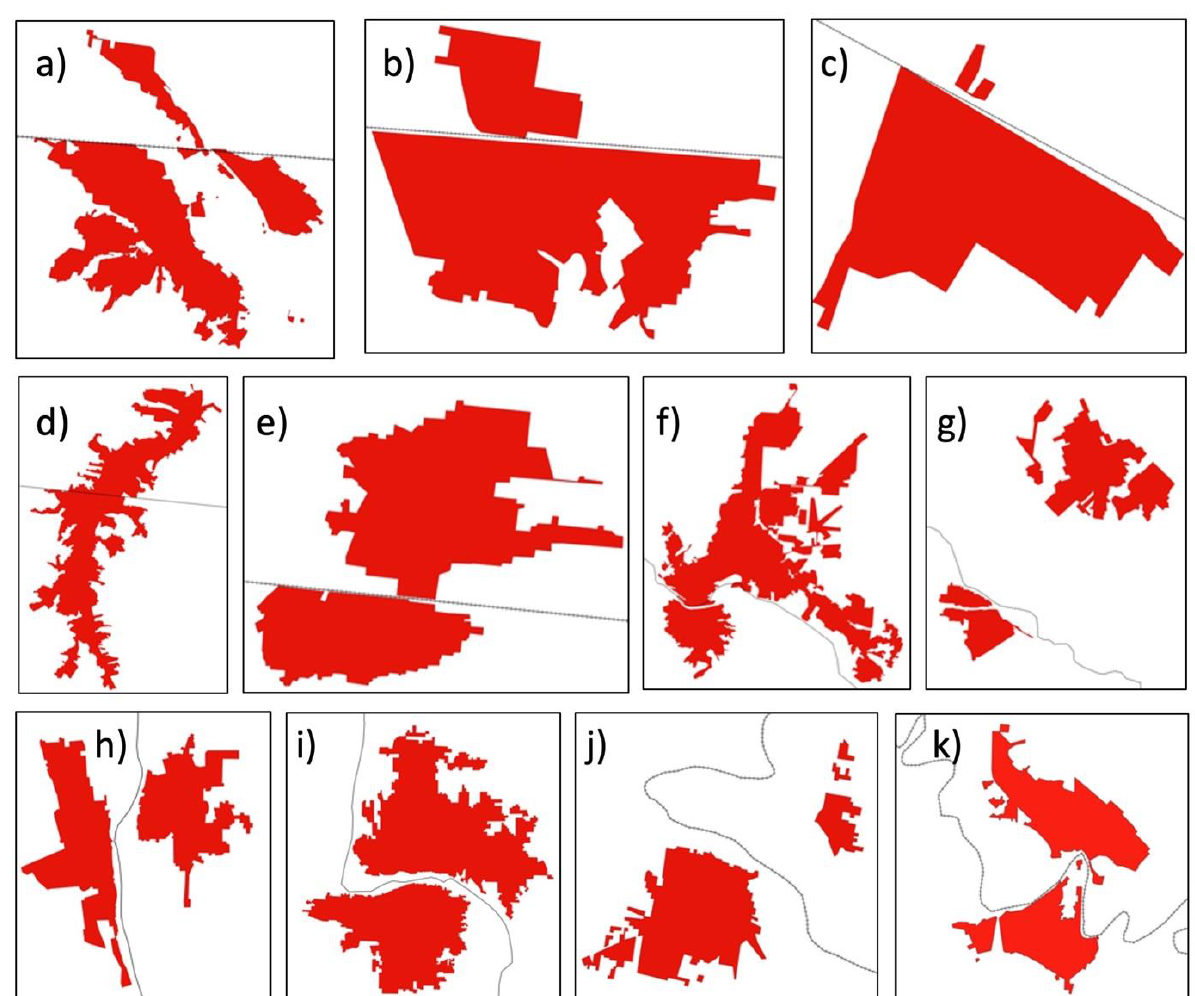
Figure 2. Urban areas in the 1940s–1950s extracted from aerial images; ( a ) San Ysidro and Tijuana 1955, ( b ) Mexicali and Calexico 1953, ( c ) San Luis Rio C./San Luis 1949, ( d ) Nogales 195; ( e ) Agua Prieta and Douglas 1958, ( f ) Ciudad Juárez and El Paso 1956, ( g ) Ciudad Acuna and Del Rio 1950, ( h ) Piedras Negras and Eagle Pass 1947; ( i ) Nuevo L. and Laredo 19, ( j ) Reynosa and Hidalgo 1946, ( k ) Matamoros and Brownsville 1946.